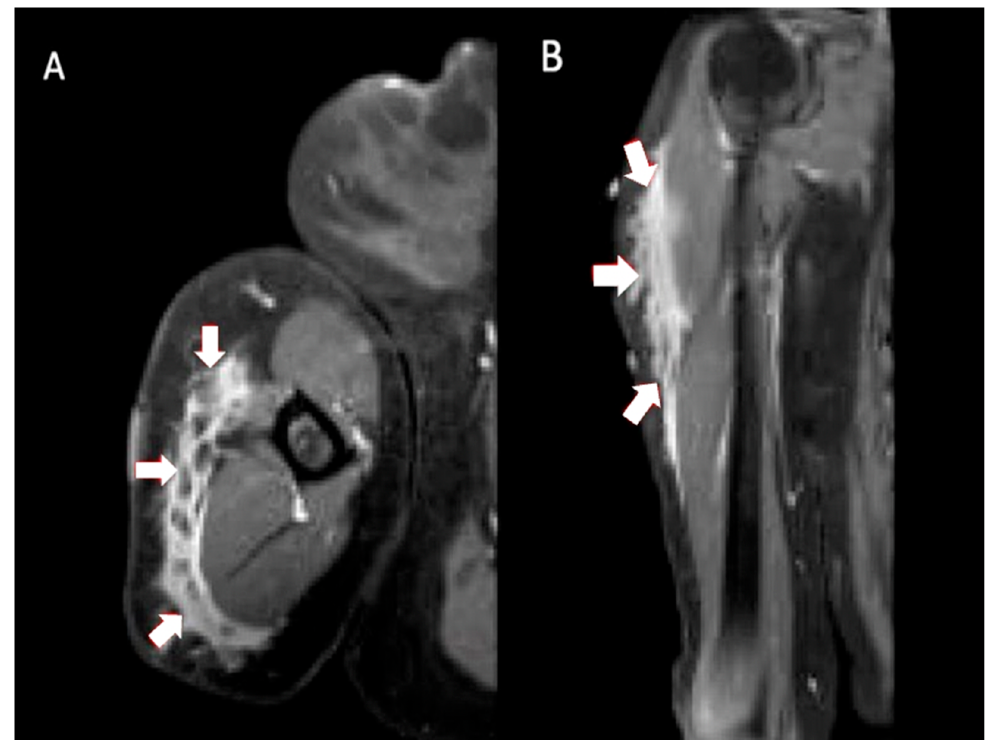
Figure 1. Multiplanar MRI of right shoulder taken 8 months after vaccine administration in right shoulder. Axial T2 ( A ) and coronal T2 ( B ) images show ill-defined fluid signal surrounding inter- spersed areas of fat. The involved area extended from surgical neck of the humerus to distal diaphysis, measuring approximately 14.9 × 8.2 × 1.8 cm (arrows).